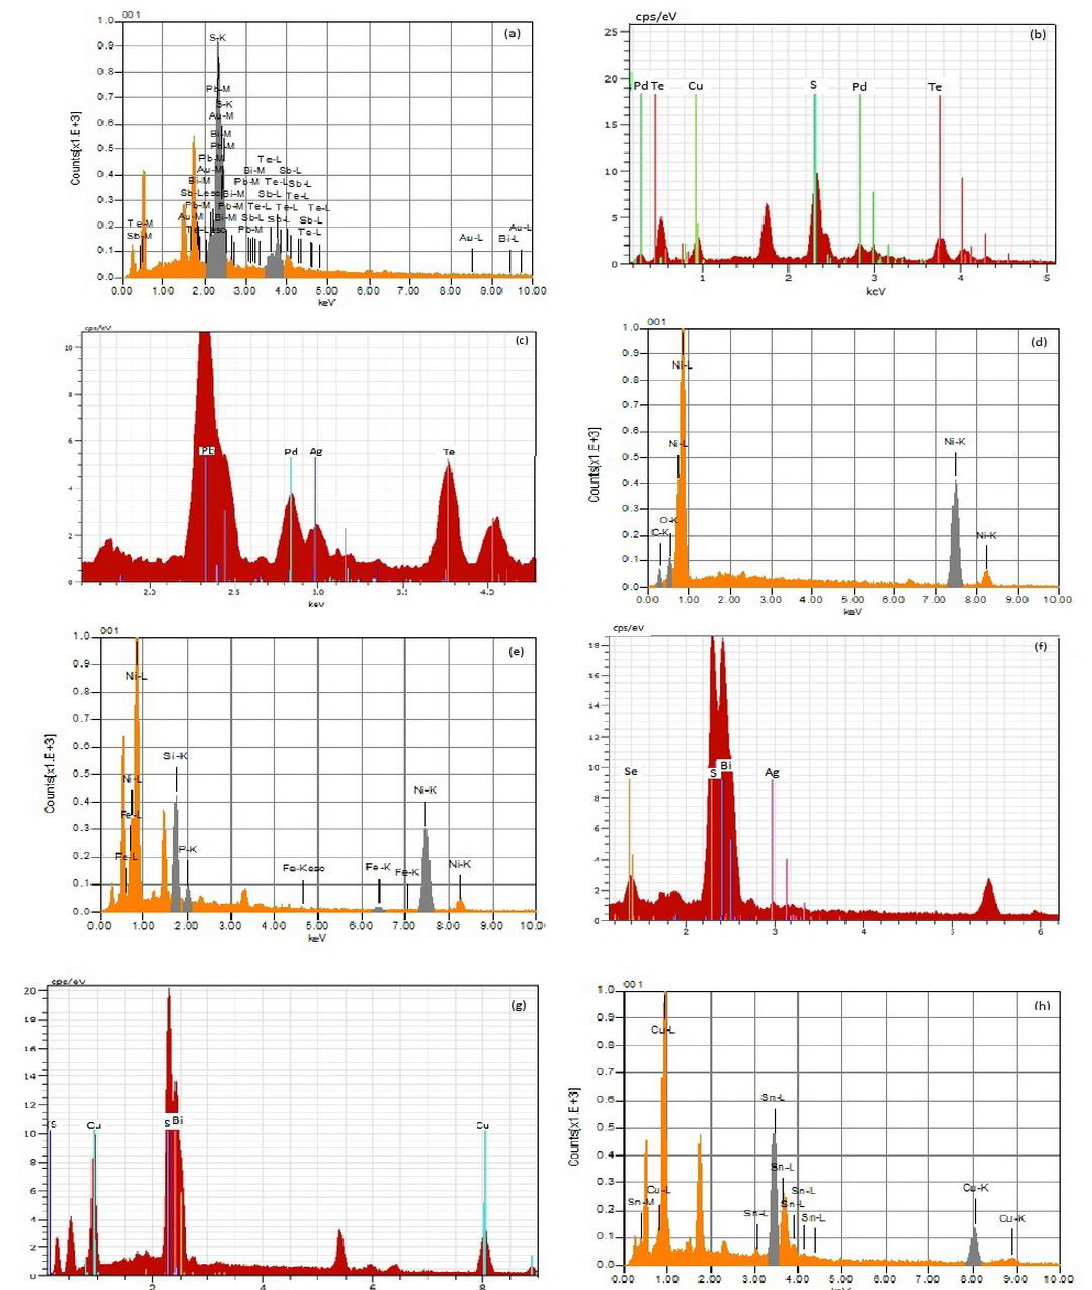
Figure 7. SEM-EDS spectra of several rare minerals and metals found in the samples from Assarel mine. ( a ) nagyagite; ( b ) merenskyite (Fe and S are from host pyrite); ( c ) pasavaite (?); ( d ) native nickel; ( e ) perryite (?); ( f ) bismuthinite; ( g ) wittichenite, ( h ) sorosite. Spectra ( a , d , e , h ) were obtained at Rice University (grey peaks are main peaks, used for quantification, while orange peaks are secondary peaks); spectra ( b , c , f , g ) were obtained at the Geological Institute of Romania.